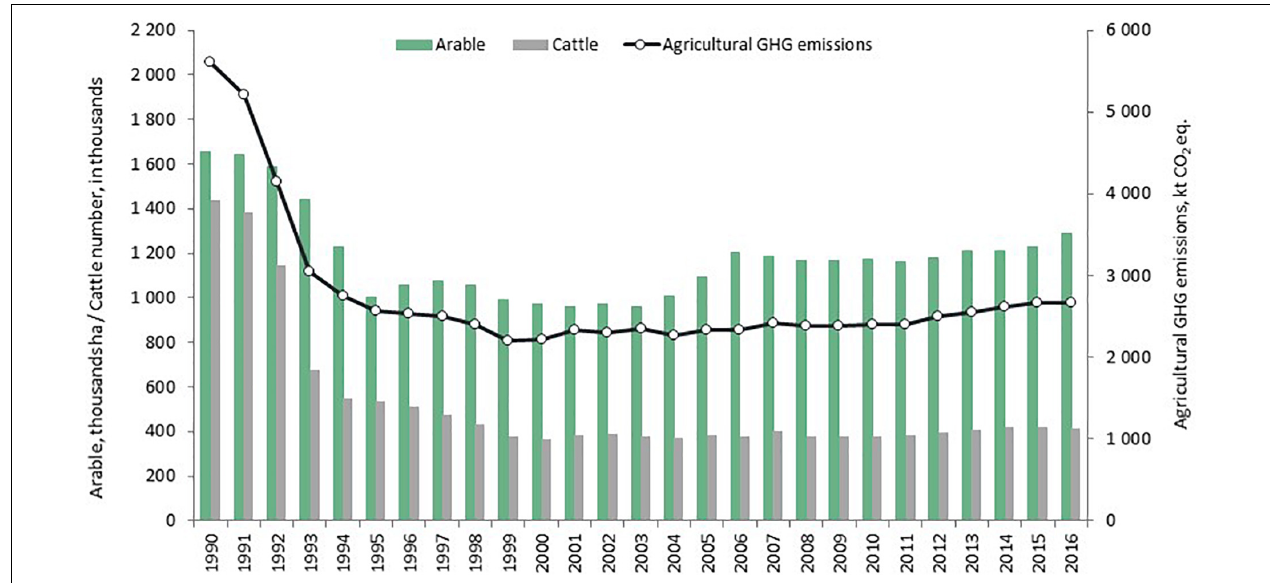
FIGURE 2 | Area of tilled land (thousands of ha), number of cattle (thousands of heads) and annual GHG emissions (kt CO 2 equivalent) for Latvia (NIR, 2018).